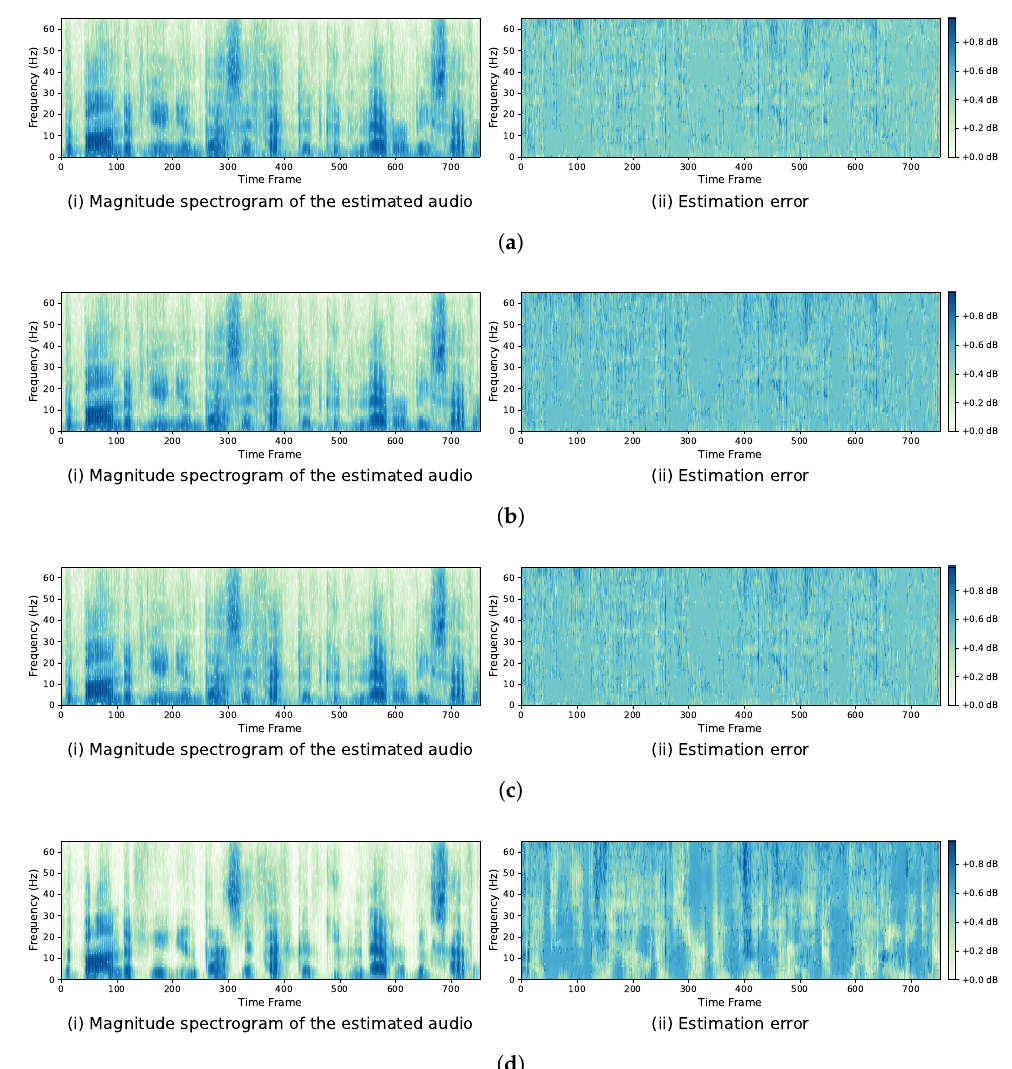
Figure 5. The estimated spectrograms and estimation error diagrams of VoiceFilter model. The x -axis represents the time frame, the y -axis represents the frequency, and the unit of color scale is dB. ( a ) The estimated magnitude spectrogram (i) and the estimation error (ii) of the VoiceFilter model integrating MFCCs features using DC fusion method. ( b ) The estimated magnitude spectrogram (i) and the estimation error (ii) of the VoiceFilter model integrating MFCCs features using ECC fusion method. ( c ) The estimated magnitude spectrogram (i) and the estimation error (ii) of the VoiceFilter model integrating MFCCs features using CEC fusion method. ( d ) The estimated magnitude spectrogram (i) and the estimation error (ii) of the VoiceFilter model integrating d-vector features using ECC feature fusion